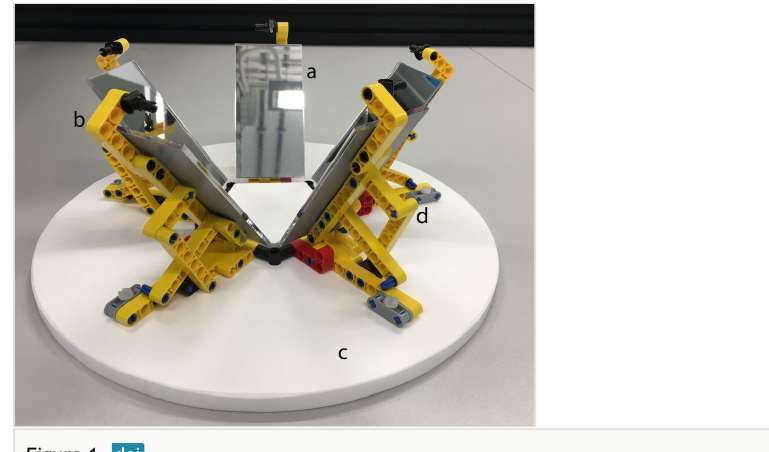
Figure 1. MALICE vial setup showing the acrylic mirrors (a) LEGO mirror tilt arms (b), formex base (c) and LEGO friction joint